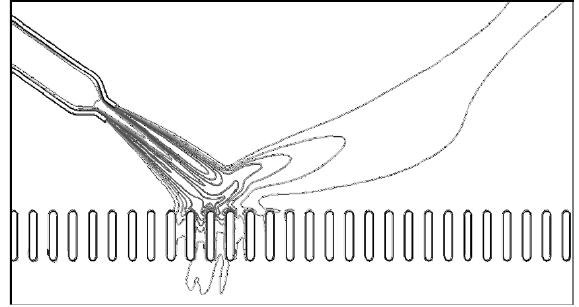
Fig. 15. Computed contours of absolute magnitudes of the air velocity in the same solution domain as in Figs. 12, 13, 14. Remarkable is the complexity of this flowfield.